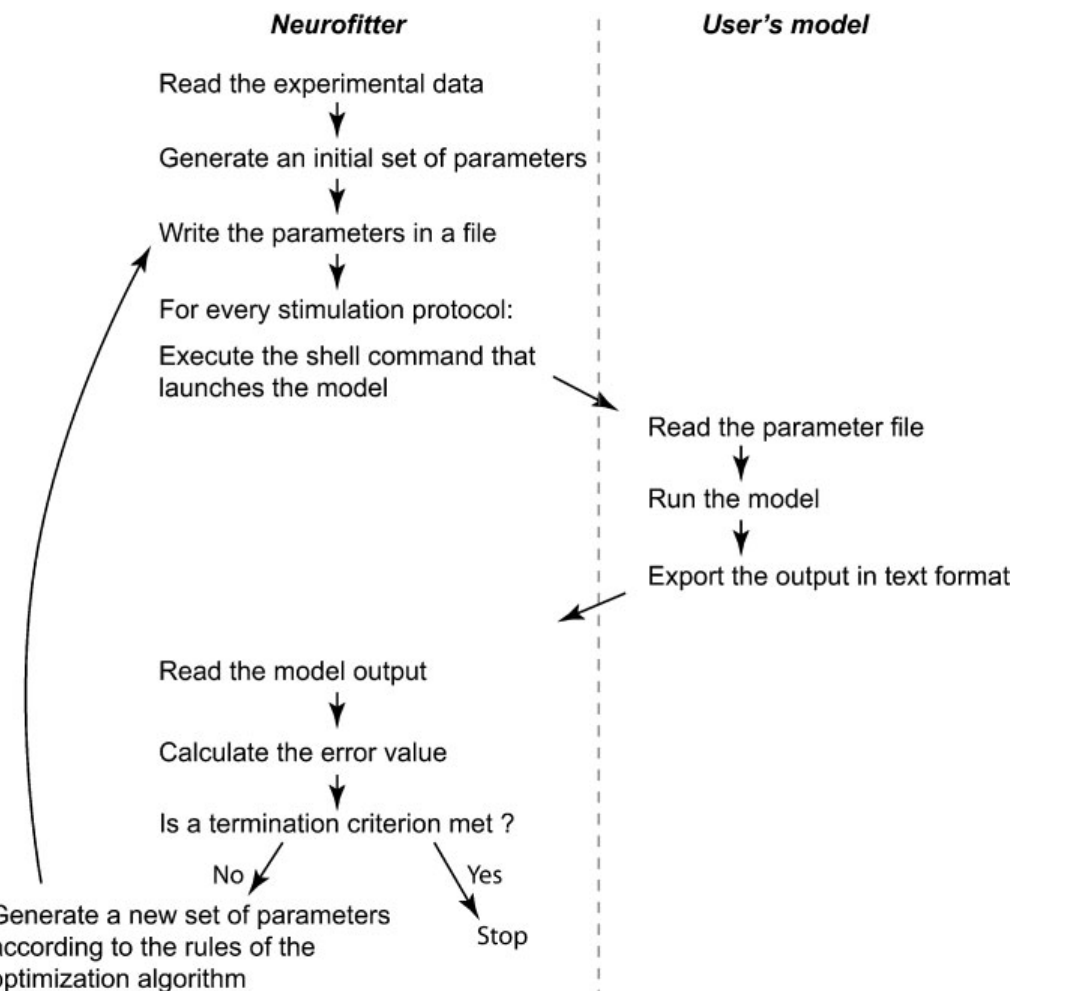
Figure 1. General algorithm . Short description of the core operations of the algorithm. The left panel contains the steps performed by Neurofitter; the right panel the actions the user has to implement in the neuron model code.